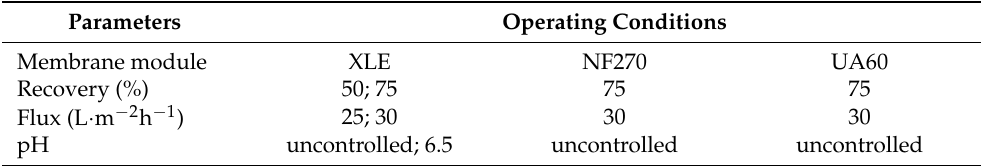
Table 1. Pilot plant operating conditions [8].